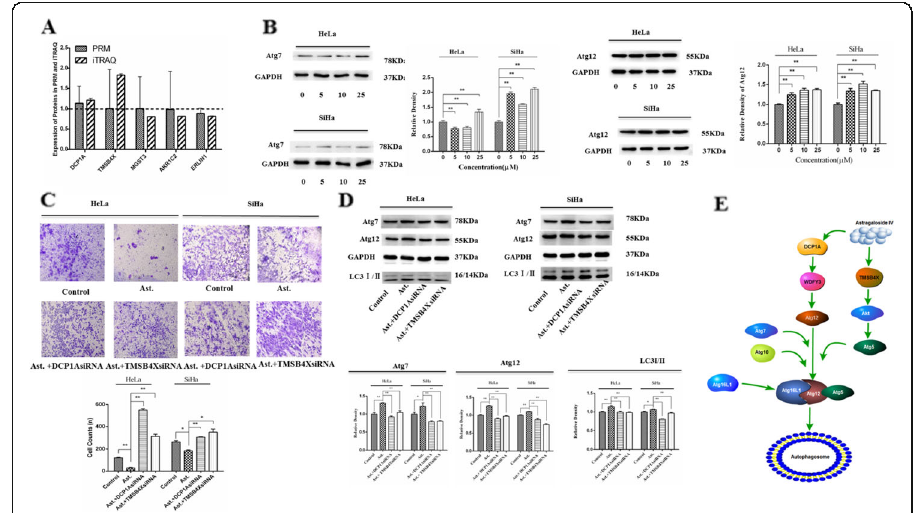
Fig. 5 AS-IV induces autophagy and suppresses cervical cancer invasion by targeting DCP1A and TMSB4X. a Differentially expressed protein quantification by mass spectrometry-based targeted proteomics (PRM). b Expression of Atg7 and Atg12 in SiHa and HeLa cells was measured by western blot in the presence of AS- IV of different concentrations treated for 12 h. c SiHa and HeLa cells were treated with AS-IV in the presence of DCP1A siRNA or TMSB4X siRNA for 12 h and cell invasion was measured by transwell chamber culture. d SiHa and HeLa cells were cultured with AS-IV in the presence of DCP1A siRNA or TMSB4X siRNA for 12 h, and the expression of Atg7, Atg12, and LC3I/II was measured by western blot. e Mechanism map of AS-IV inducing autophagy through the TMSB4X/Akt/Atg5/Atg12 and DCP1A/WDFY3/Atg12 pathways. Results are presented as mean ± standard deviation, n = 3. * P < 0.05 and ** P < 0.01 in comparison to the control group (0 μ M AS-IV or AS-IV treated